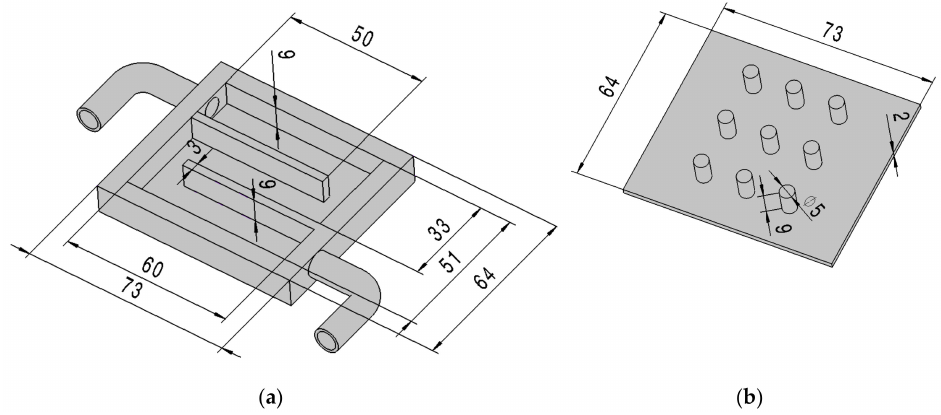
Figure 2. ( a ) Dimensions of the cooling block; ( b ) dimensions of the finned plate